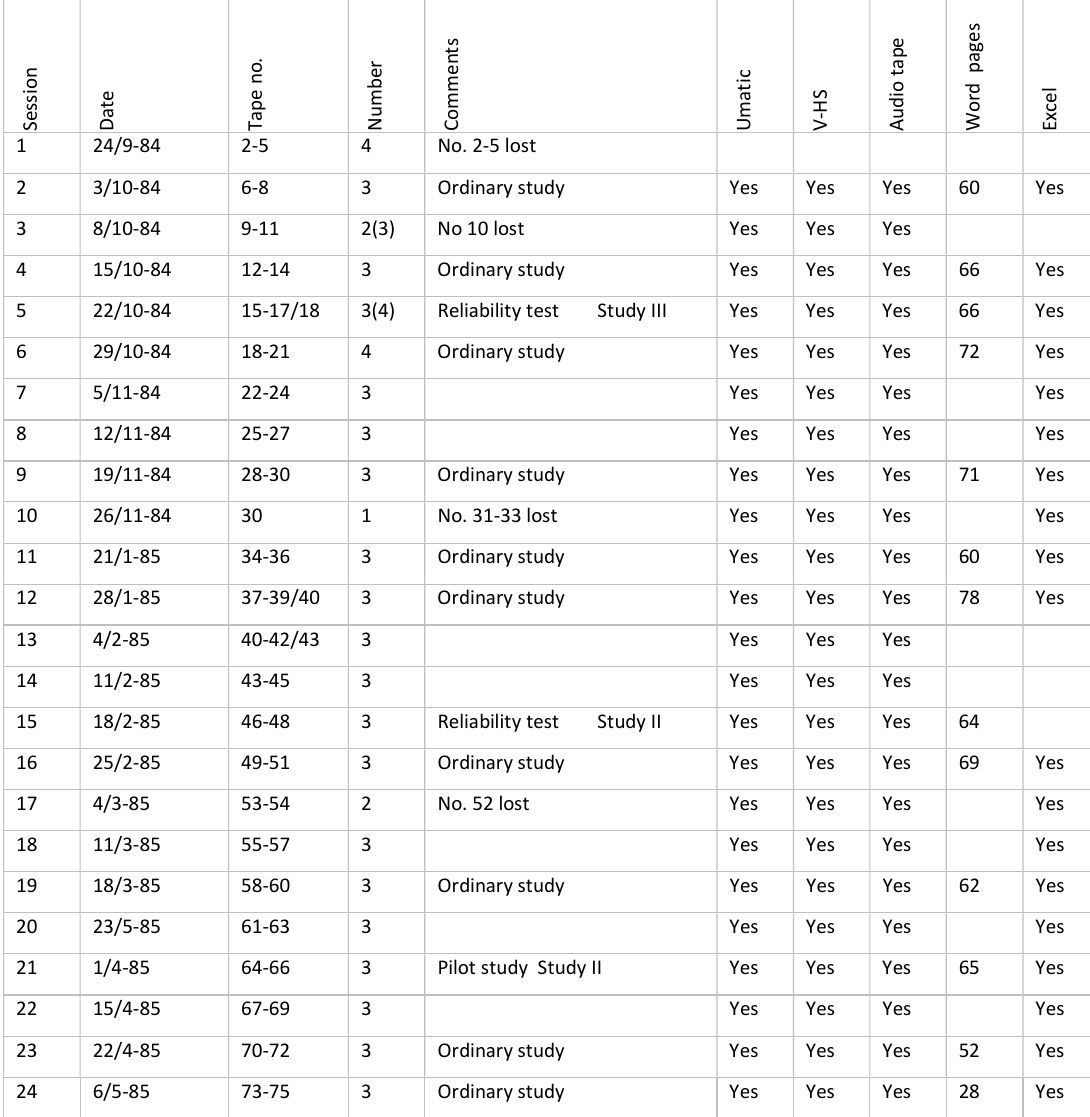
Table 3: The basic study material from the TA group therapy